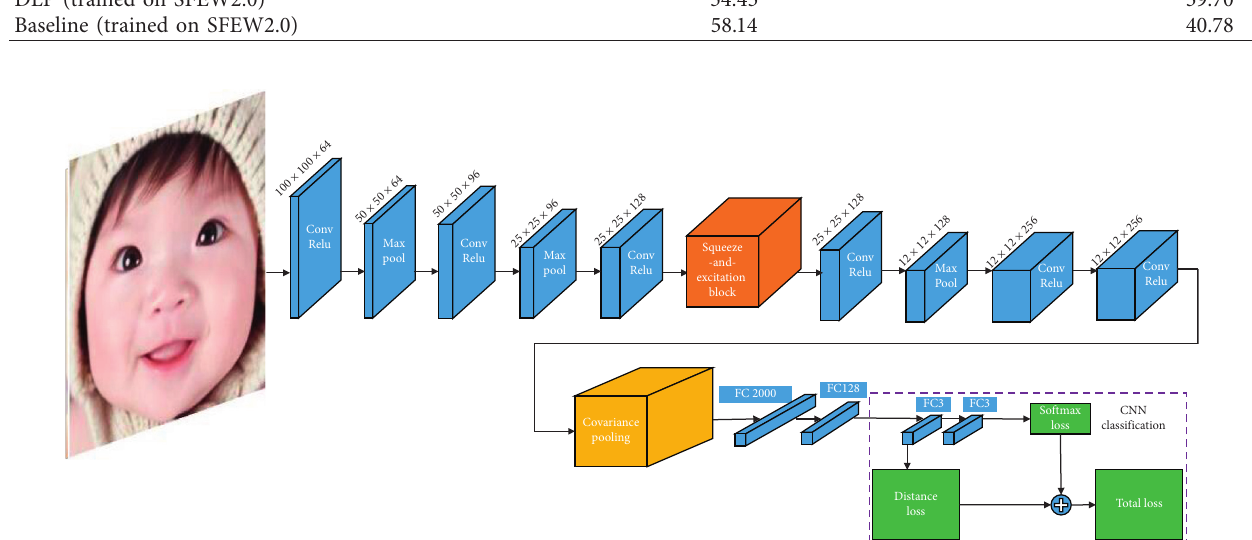
Figure 5: The overall architecture of the deep learning approach SO-DLSE. Table 4: The expression recognition performance of different methods on the BabyExp dataset (trained from scratch).